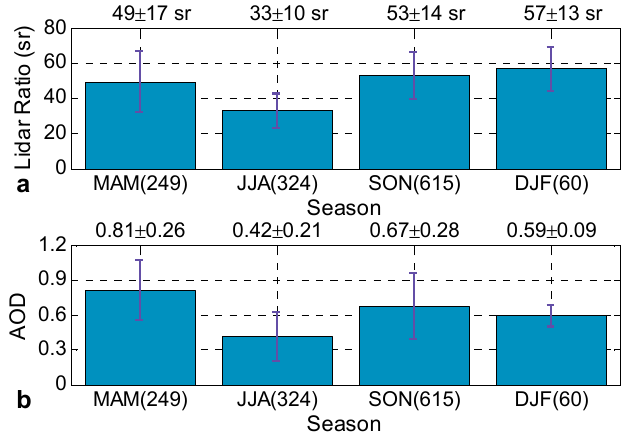
Figure 5. Seasonal ( a ) mean aerosol lidar ratios and ( b ) AODs at 532 nm derived from Raman lidar measurements in Wuhan between July 2013 and May 2015. The numbers in each bracket represent the number of available results of the corresponding season. The error bars represent the corresponding standard deviations.